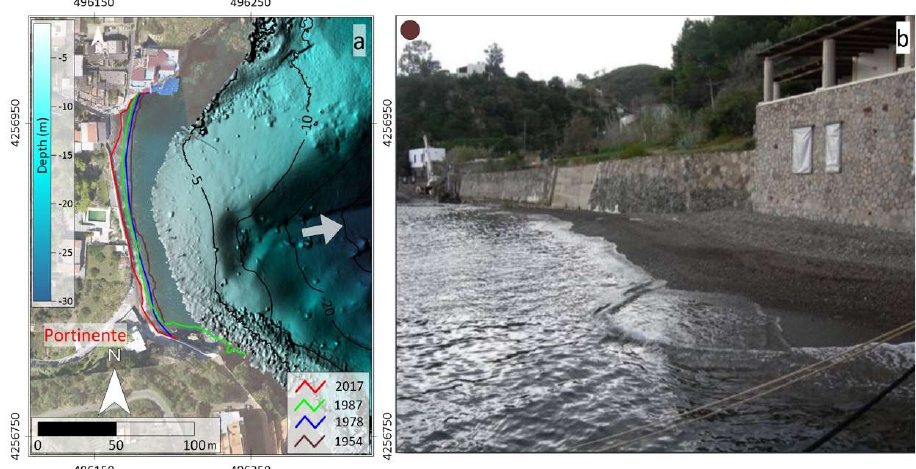
Figure 12. Map of Baia Portinente beach and related reconstructed shorelines ( a ) and image of the setting in November 2017 ( b ); see Figure 1 for location. White arrow shows the active canyon heads located in the nearshore.